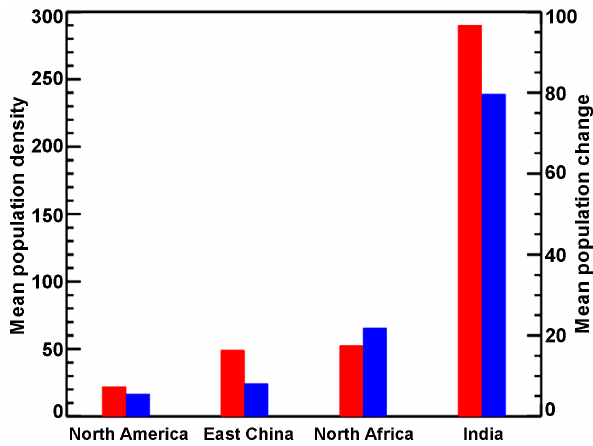
Figure 6. Global distribution of mean population density (per- sonskm − 2 ) .